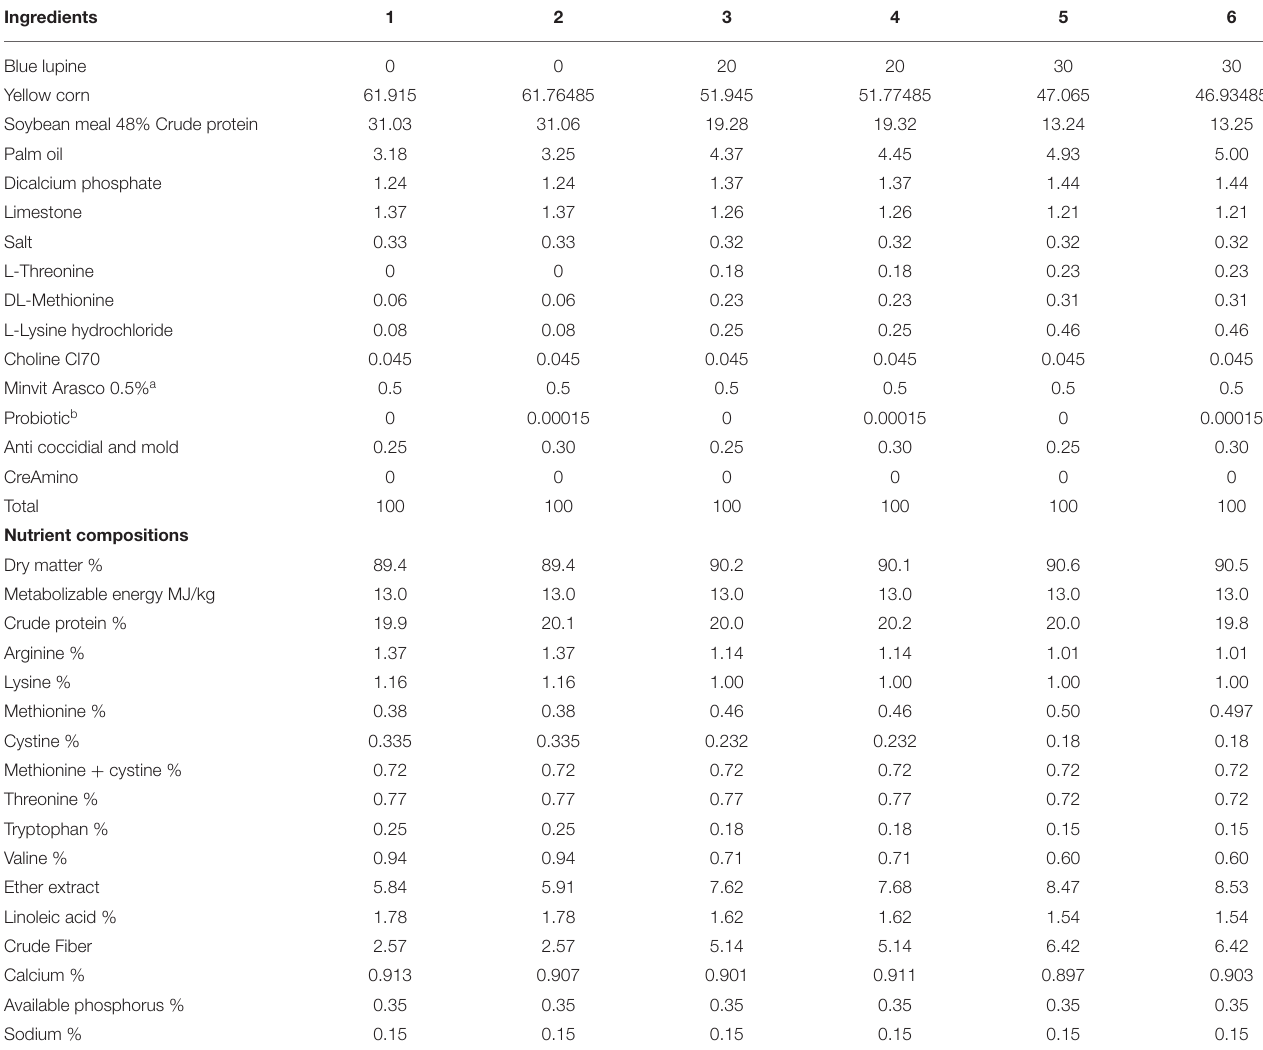
TABLE 2 | The composition of the diets used in the experiment